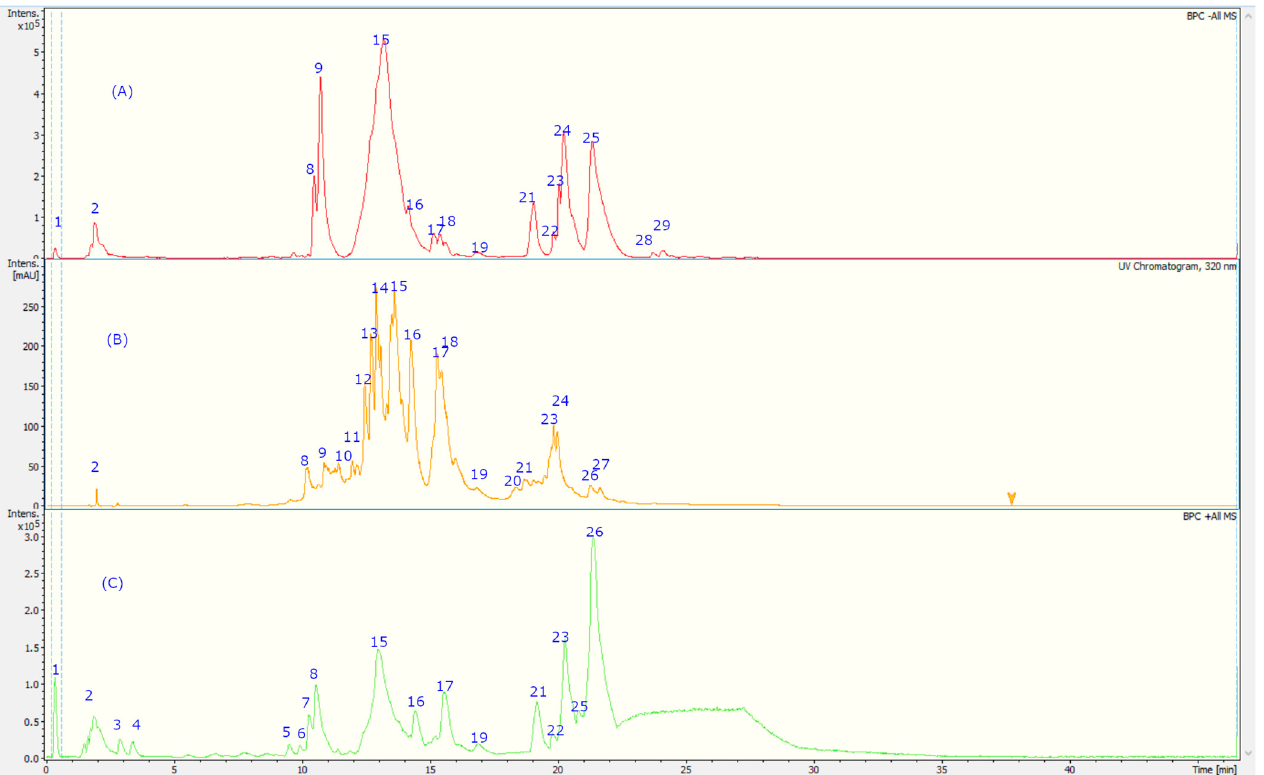
Figure 2. UHPLC-TIC chromatogram of A. dentata extract with ( A ) negative MS mode, ( B ) UV at 320 nm, and ( C ) positive mode. The peak numbers refer to the compounds identified in Table 2.